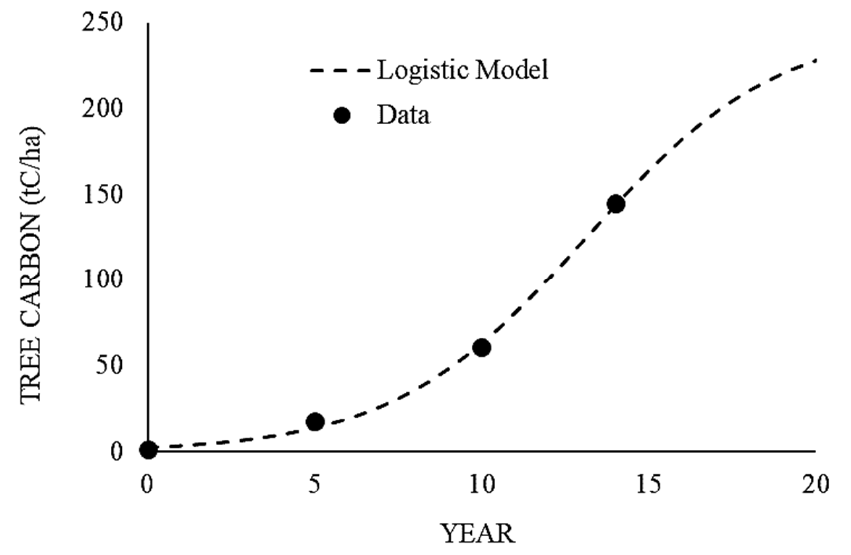
Figure 2. Modeled tree-carbon accumulation during forest restoration by the framework species method, including above- and below-ground parts.